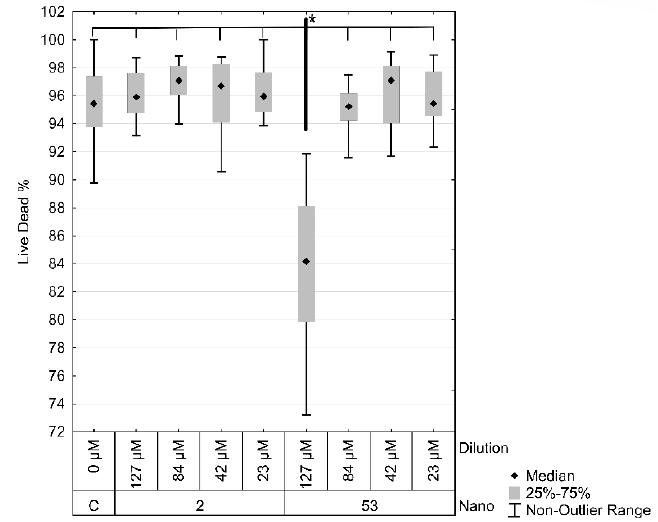
Figure 7. Effect of Laser ablated Albumin functionalized AuNPs (LA-AuNPs) on Adipose-derived stromal cells (ASCs) on cellular cytotoxicity assessed by Live/Dead assay, presented as survival percentage. Cells were exposed for 24 h to four different concentrations of nanoparticles with two different particle sizes, 2 nm, and 53 nm, in four dilutions: Control (C), 1:1 (127 µ M), 1:2 (84 µ M), 1:5 (42 µ M) and 1:10 (23 µ M). Data analyzed by Kruskal-Wallis’s test and represented as median ± 25–75%. * Significantly lower viability.